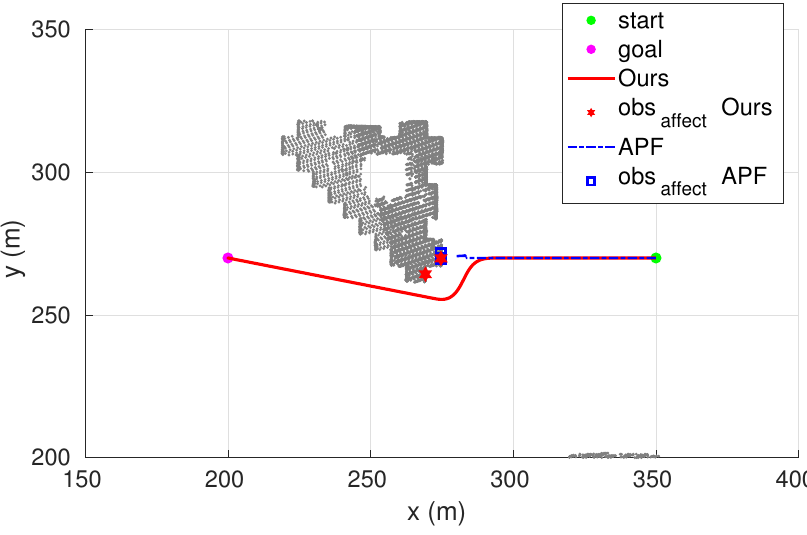
Figure 5. Bird’s eye view of the local minima problem case.